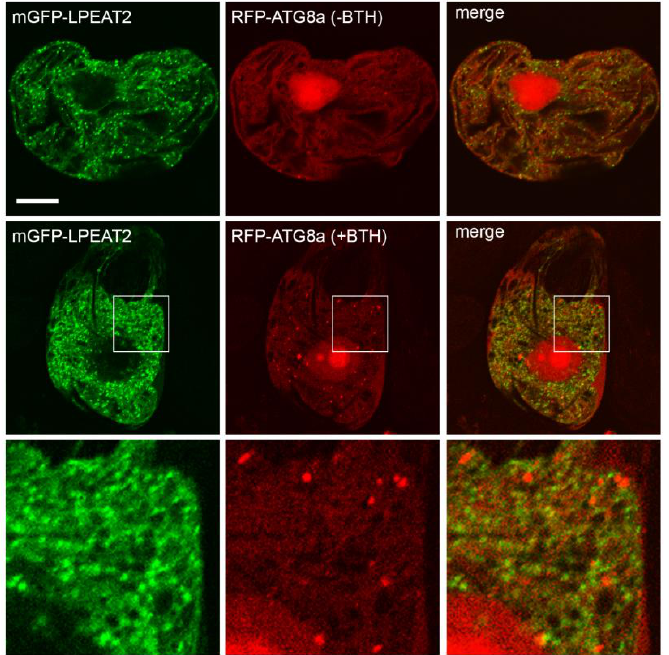
Figure 3. Arabidopsis LPEAT2 does not colocalize with the autophagosomal marker ATG8 in cells in the absence or presence of autophagy inducer BTH. BY-2 cells were transiently-cotransformed (as indicated by labels) with mGFP-LPEAT2 (green) and RFP-ATG8a (red) and incubated with or without 10 µM BTH. Cells were subsequently formaldehyde-fixed and processed for CLSM. Shown are representative images, as well as the corresponding merged images for each set of cotransformed cells. Boxes represent the portion of the cell co-expressing mGFP-LPEAT2 and RFP-ATG8a and incubated with BTH shown at higher magnification in the panels below. Note an increase in the number of RFP-ATG8-labelled puncta upon induction of autophagy with BTH indicating formation of autophagosomes. Note also a lack of colocalization between mGFP-LPEAT2 and RFP-ATG8a. Scale bar, 10 μ m.